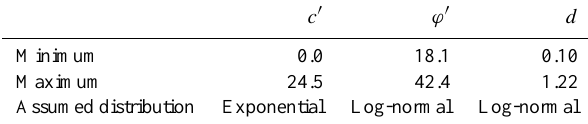
Table 3. Constraints and assumed statistical distribution of geotech- nical parameters and soil depth for the generation of a